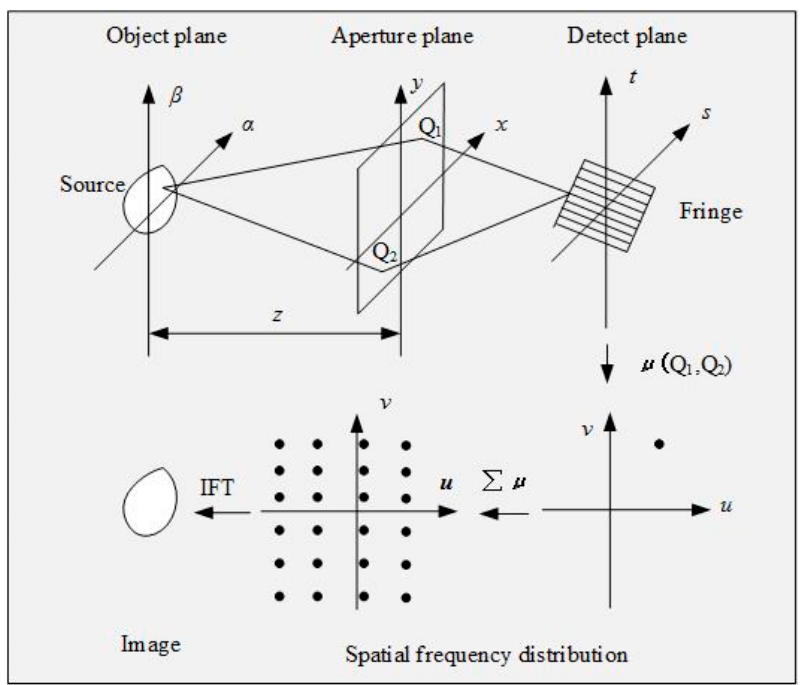
Figure 2. Schematic of the cutting-edge electro-optical imaging